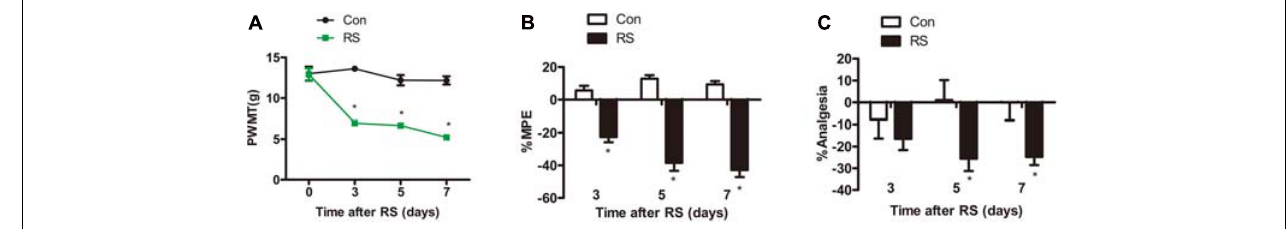
FIGURE 1 | Mechanical or thermal nociceptive thresholds in rats with or without chronic RS. (A–C) Nociceptive behavior tests including PWMT (RS effect: F 1 , 22 = 192.322, P < 0.001; observation intervals: F 3 , 66 = 22.641, P < 0.001; interaction: F 3 , 66 = 16.798, P < 0.001), PWTL (RS effect: F 1 , 22 = 141.084, P < 0.001; observation intervals: F 2 , 44 = 4.606, P = 0.015; interaction: F 2 , 44 = 12.632, P < 0.001), and TFL (RS effect: F 1 , 22 = 5.457, P = 0.029;